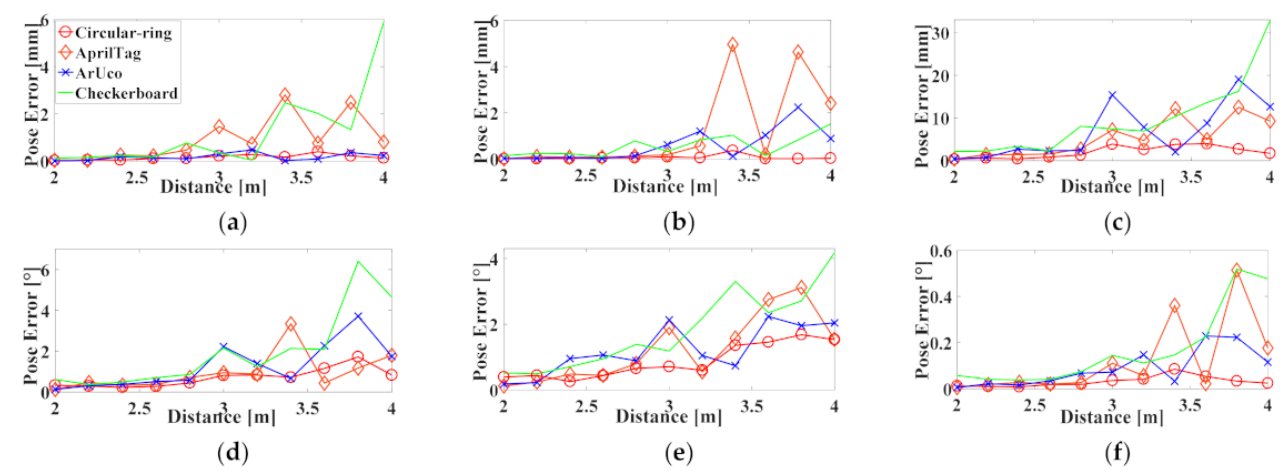
Figure 11. Six DoF correspond to repeatability errors if these markers are at 0 ◦ : ( a ) Translation error along X-axis; ( b ) Translation error along Y-axis; ( c ) Translation error along Z-axis; ( d ) Rotation error along X-axis; ( e ) Rotation error along Y-axis; ( f ) Rotation error along